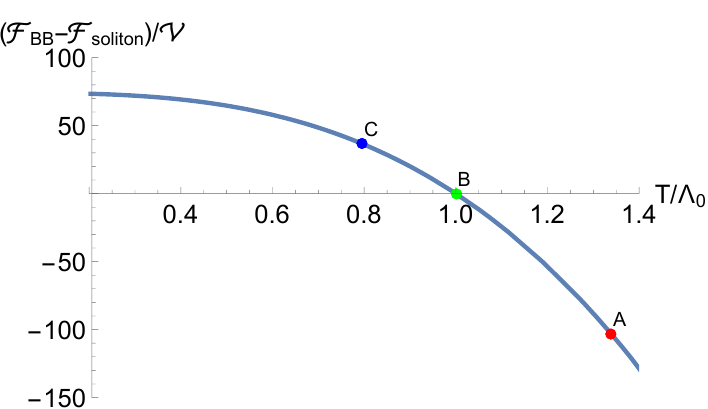
Figure 3. Free energy di(cid:11)erence at m 0 = k = 0 : 4 (cid:3) 0 . The solid line describes the di(cid:11)erence of free energies of the temperature-varying black brane along c 1 = 1 line and the AdS Q-soliton given by B in (cid:12)gure 2(a). This con(cid:12)rms that the AdS Q-soliton is dominant at T < (cid:3) 0 while the Q-lattice black brane is preferable at T > (cid:3) 0 .